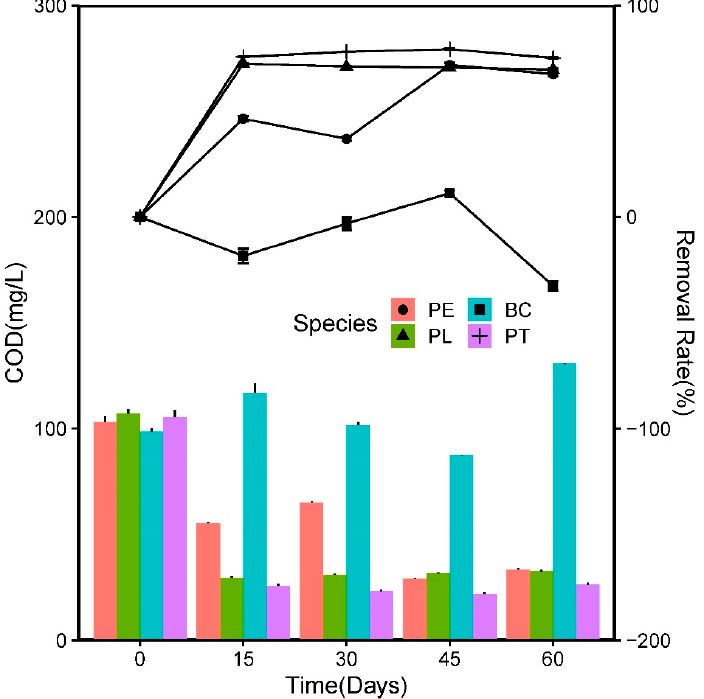
Figure 9. Variations in chemical oxygen demand (COD) concentration and the homologous removal rate in the experiment.